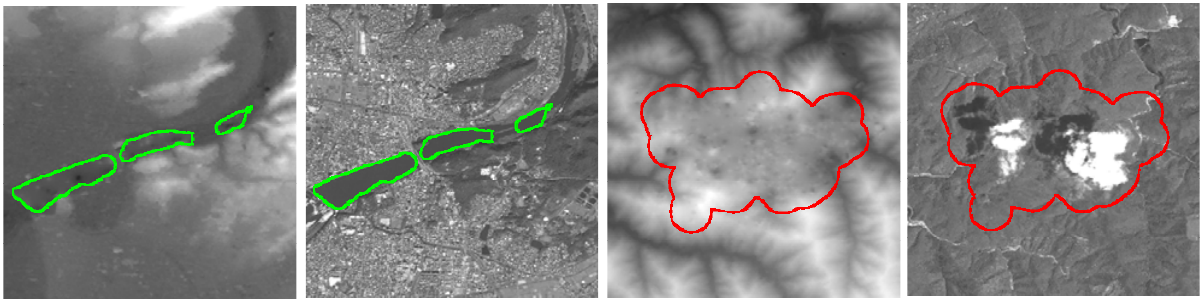
Figure 3. Added masks on water and cloud areas. Left to right: water masks on DSM gray image, water masks on nadir ORI. cloud mask on DSM gray image, cloud mask on nadir ORI. Green and red lines depict outlines of segments for the water and cloud masks respectively.